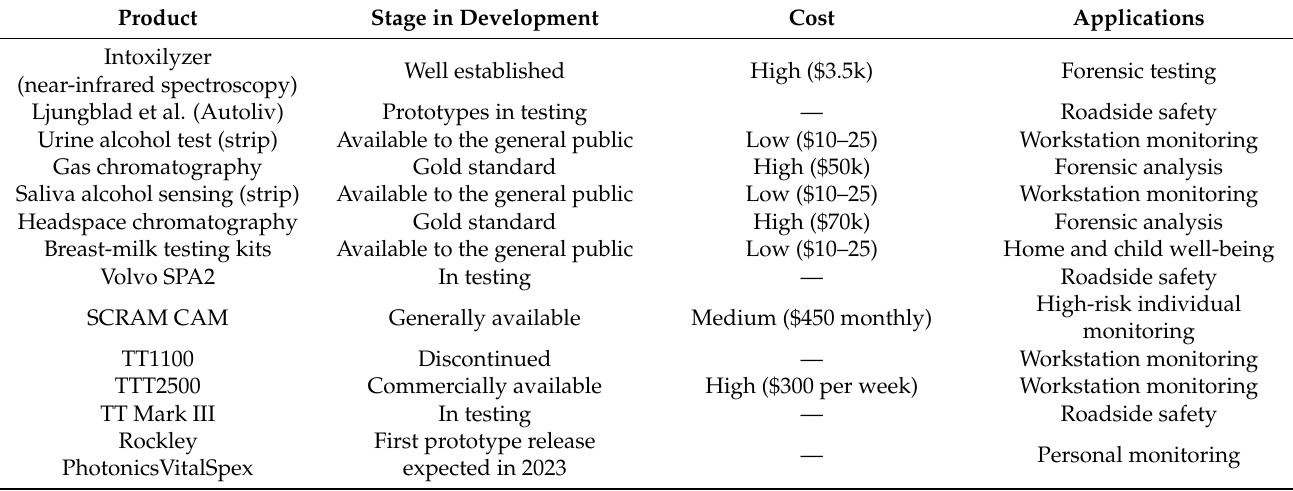
Table 3. Commercially available devices for ethanol intoxication